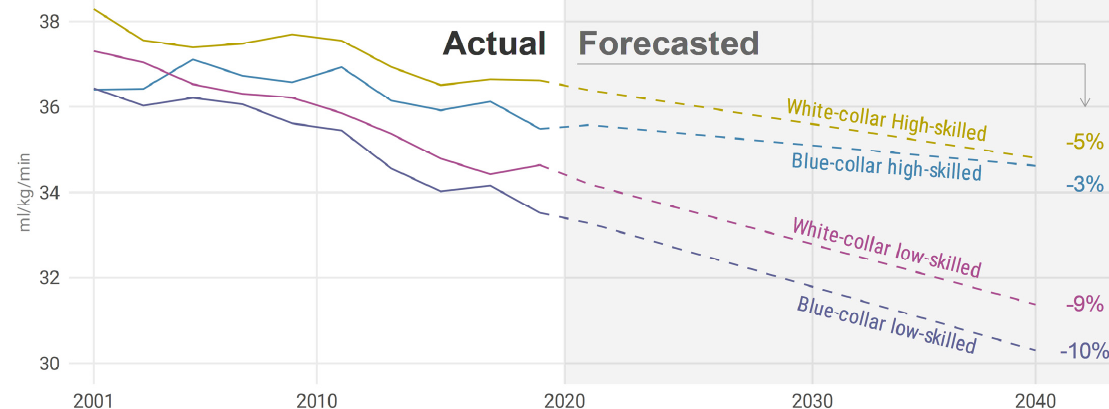
Figure 4. Actual (2001–2020) and forecasted (until 2040) trends in CRF in relation to the aggregated occupational groups. Relative percentages shown in the figure are for the forecasted period.